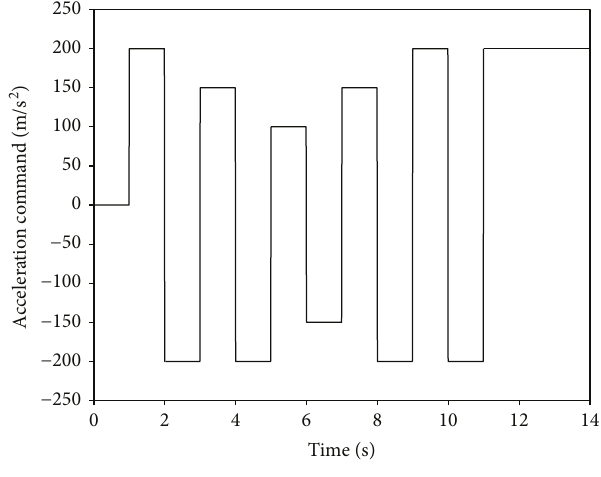
Figure 4: Trajectories of the interceptor and target under three guidance laws.